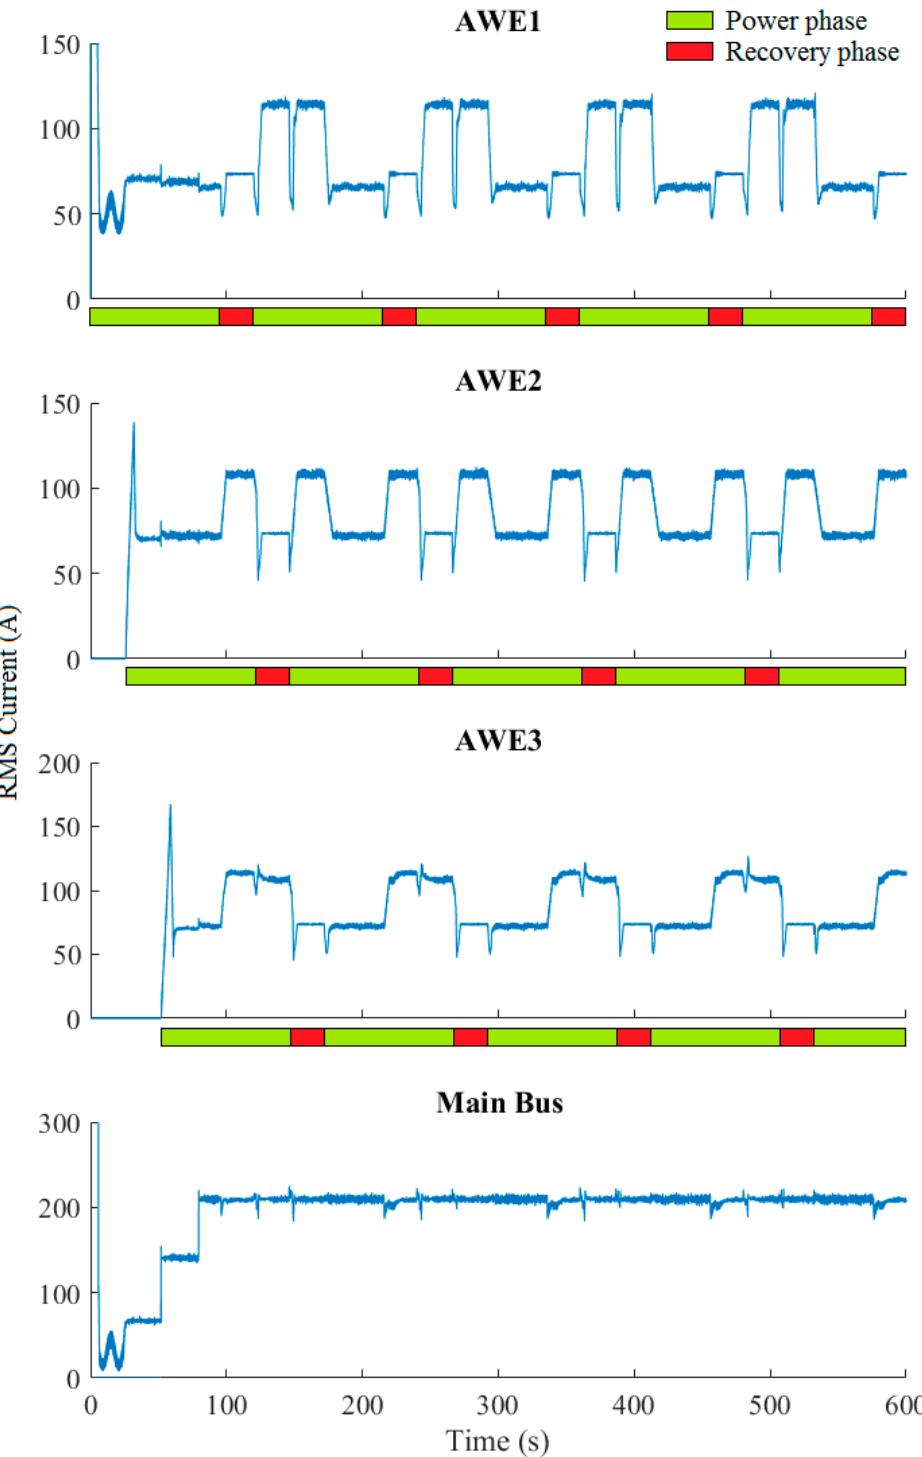
Figure 11. AWE farm currents with LSC active.